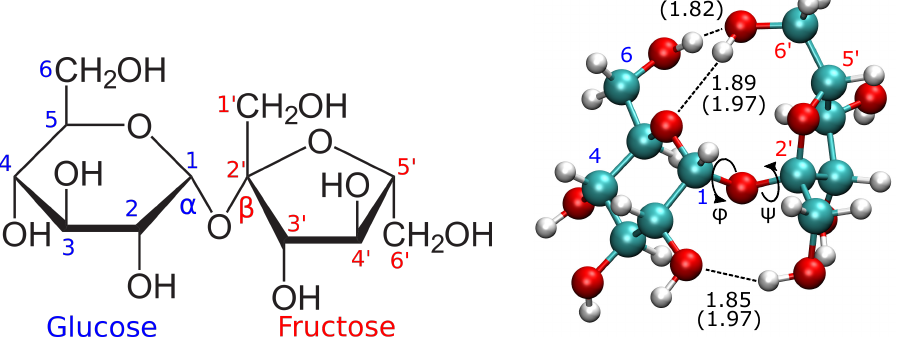
Figure 2. Haworth projection ( left ) and three dimensional atomistic representations of sucrose ( right ). The atomistic representations show the hydrogen bond distances from the crystalline structure [23] and from ab initio calculations (in parenthesis)